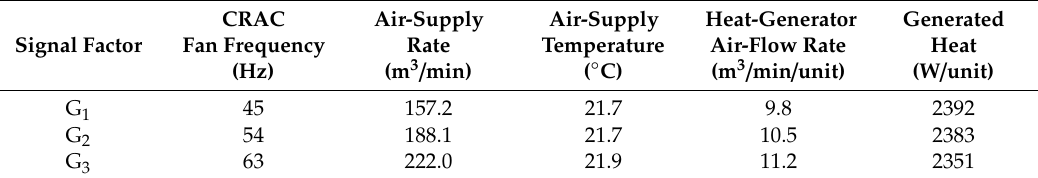
Table 5. Signal factors and conditions for computational fluid dynamics (CFD)